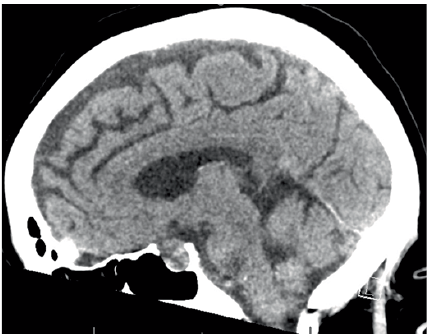
Figure 3: CT head without contrast (sagittal view) showing enlarged sella turcica with increased attenuation suggesting a possible hemorrhage within the